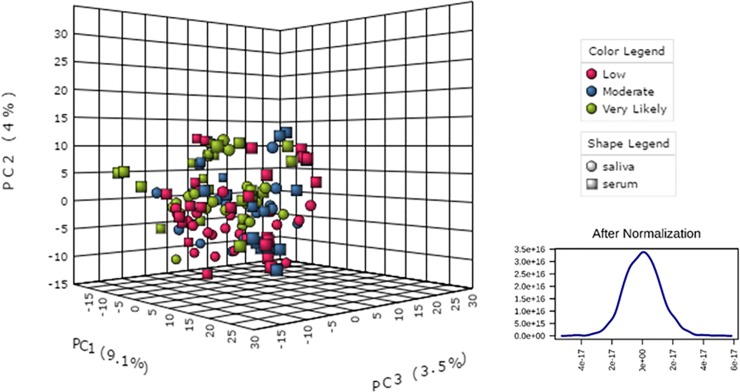
Principal component analysis (PCA) of miRNA data.The data were normalized across biofluid types and TBI likelihood prior to statistical analysis. The image at left shows intermixing of the samples, with only a slight suggestion of separation of Very Likely serum samples (green boxes) from the main data cloud. When all the data are collapsed, the change values are distributed in a highly normal fashion (lower right).